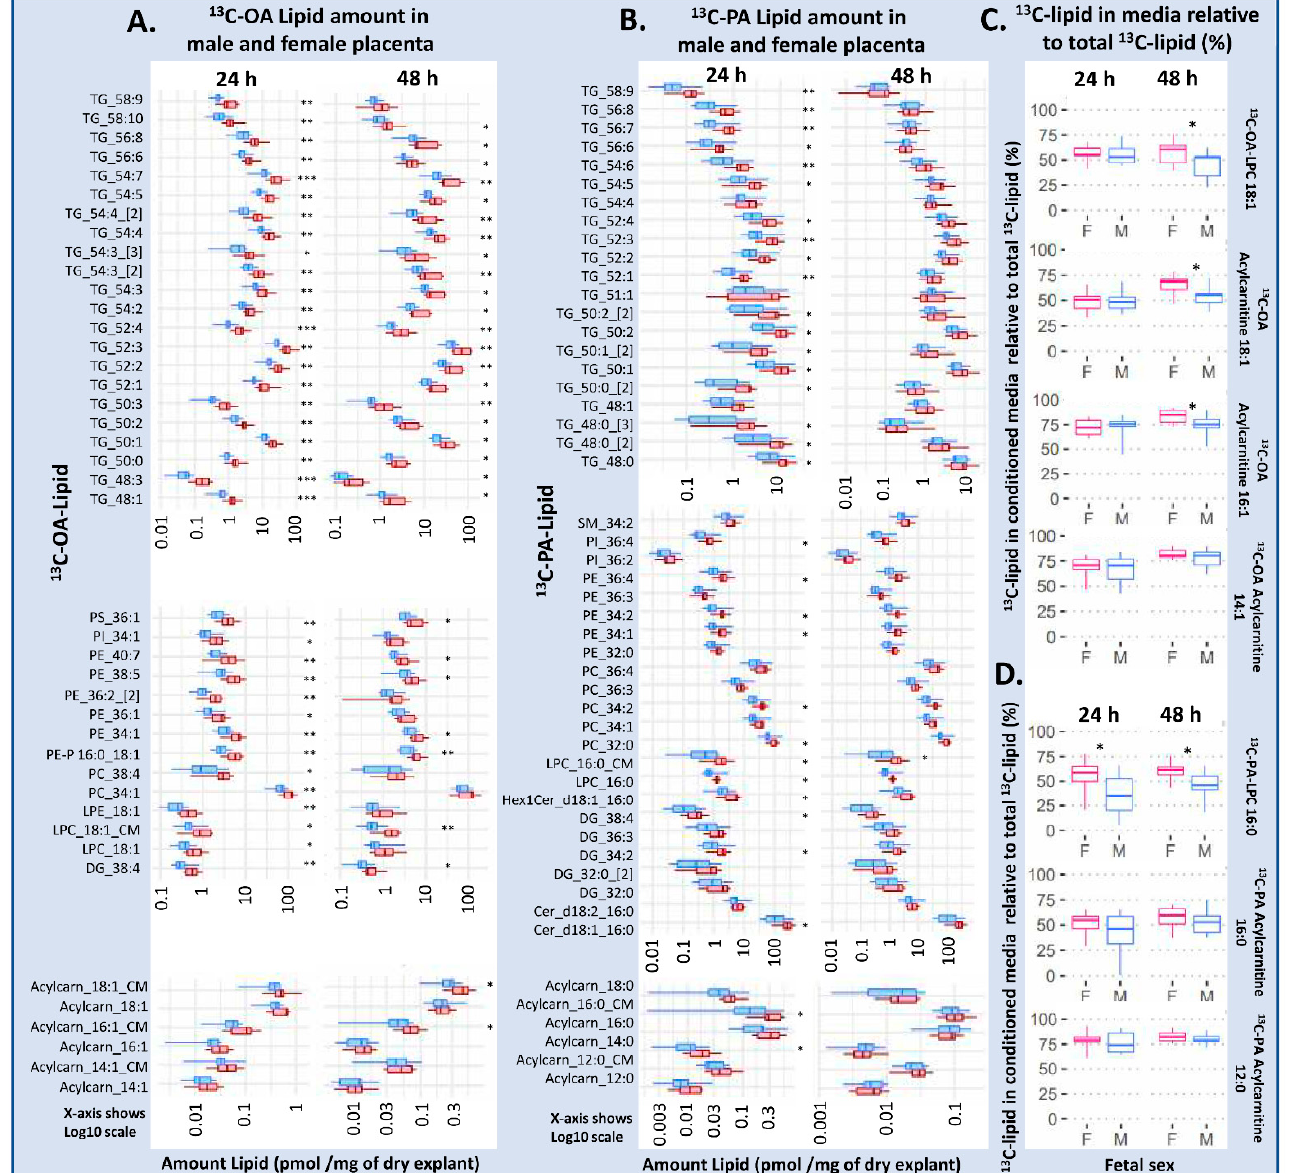
Figure 2. Differences in amount of lipid in placental explants from males (blue) and females (red) treated with 100 µM 13 C-OA ( A ), or 100 µM 13 C-PA ( B ) for 48 h. ( C , D ) The percentage of labeled lipid found in media relative to the total amount of the specific 13 C lipid in the media and explant, in males and females. Boxes and whiskers represent median, interquartile range and minimum and maximum. X axis is log10 scaled. Statistically significant differences between sexes